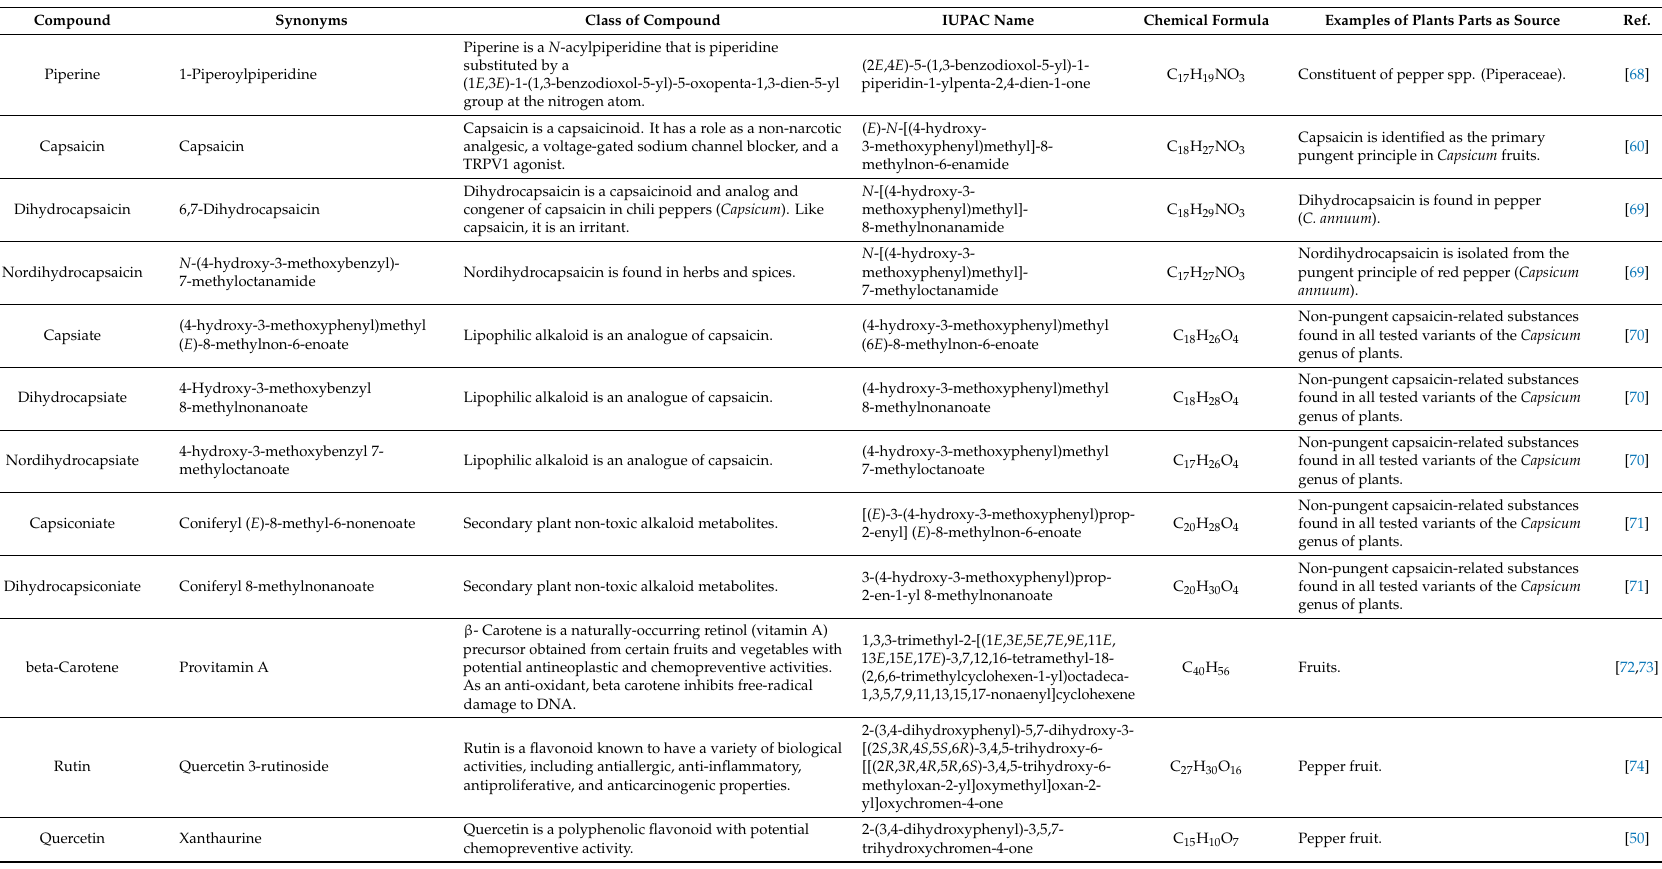
Table 5. International Union of Pure and Applied Chemistry (IUPAC) name, and the chemical formula of bioactive molecules isolated from Capsicum .